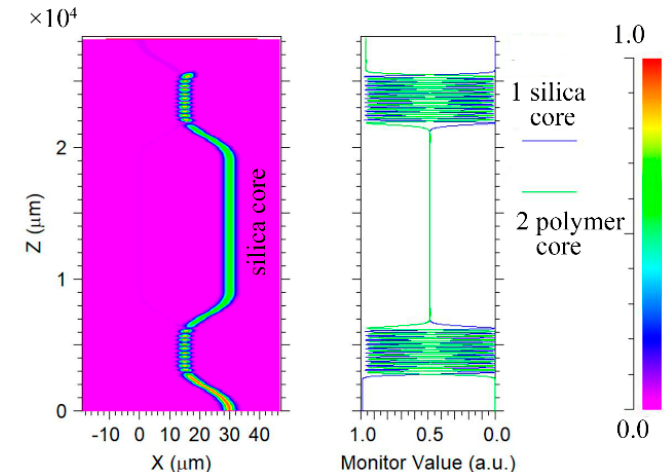
Figure 5. Simulated light field coupling is launched from silica core for the inverted TO switch with a graphene film and side electrode structure.